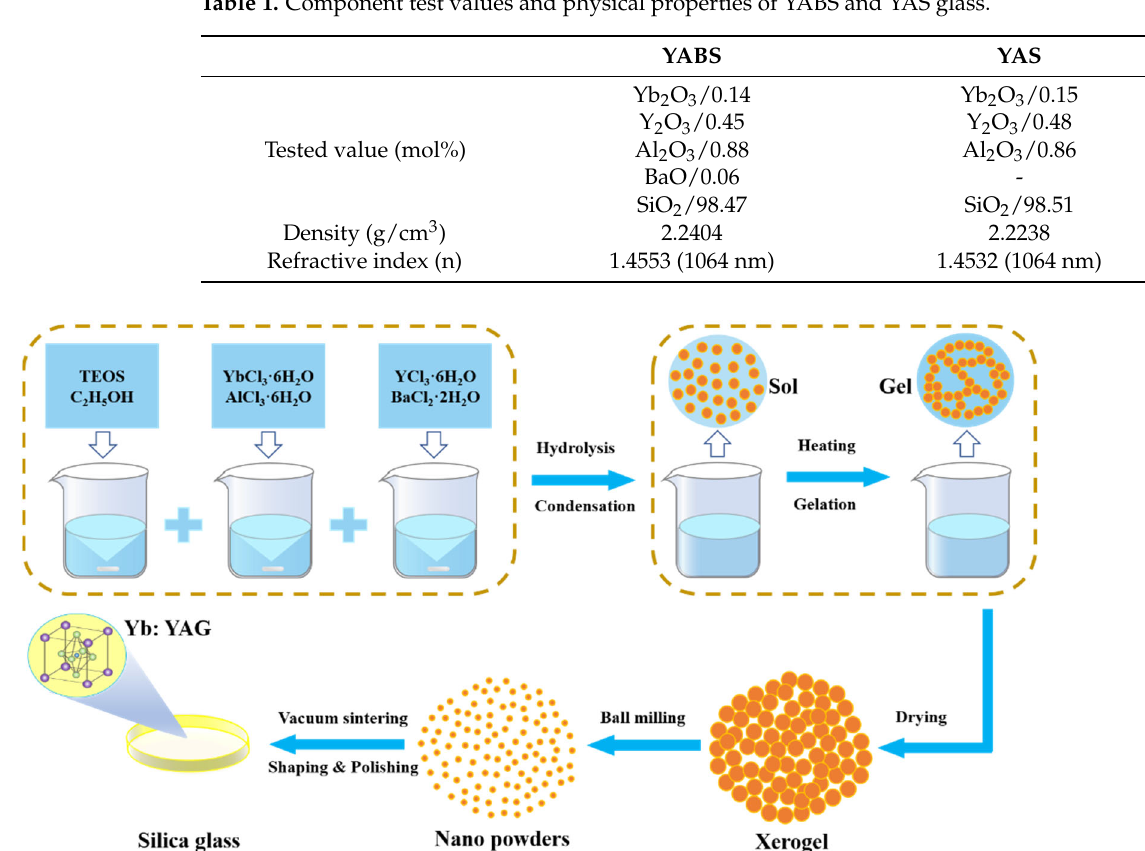
Figure 1. Flow chart for bulk glass preparation using a modified sol–gel method.